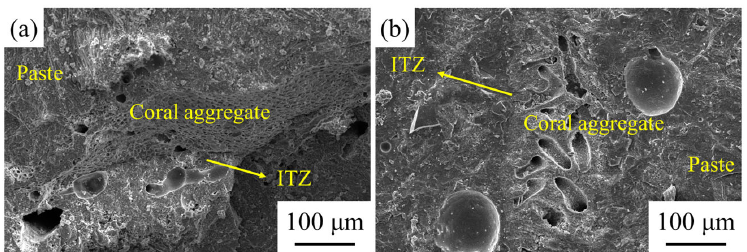
Figure 13. The SEM images of untreated and treated coral concrete: ( a ) ordinary coral concrete and ( b ) coral concrete with modified aggregate.